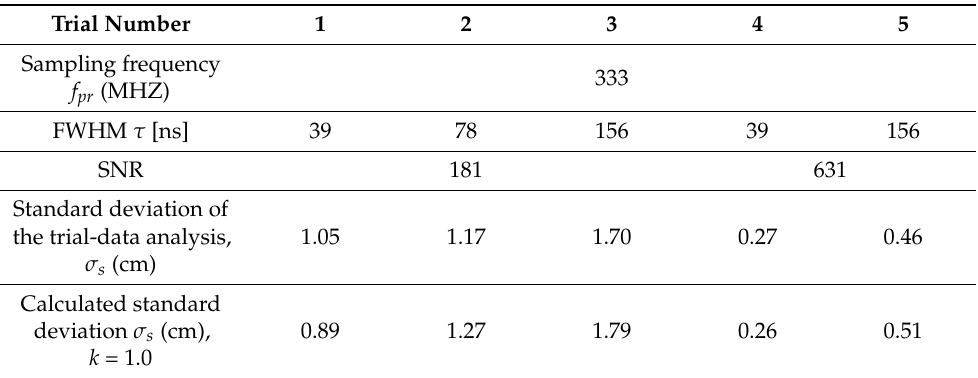
Table 5. Comparison of the results of simulation trials presented in article [13] with uncertainty estimated using Equation